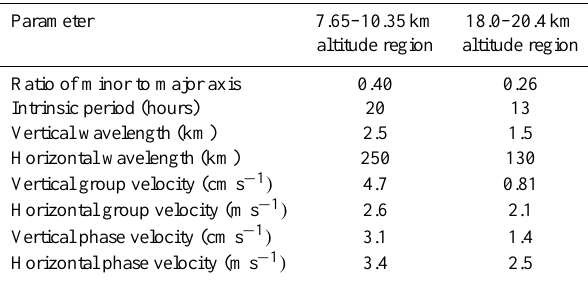
Table 1. IGW parameters over Gadanki.